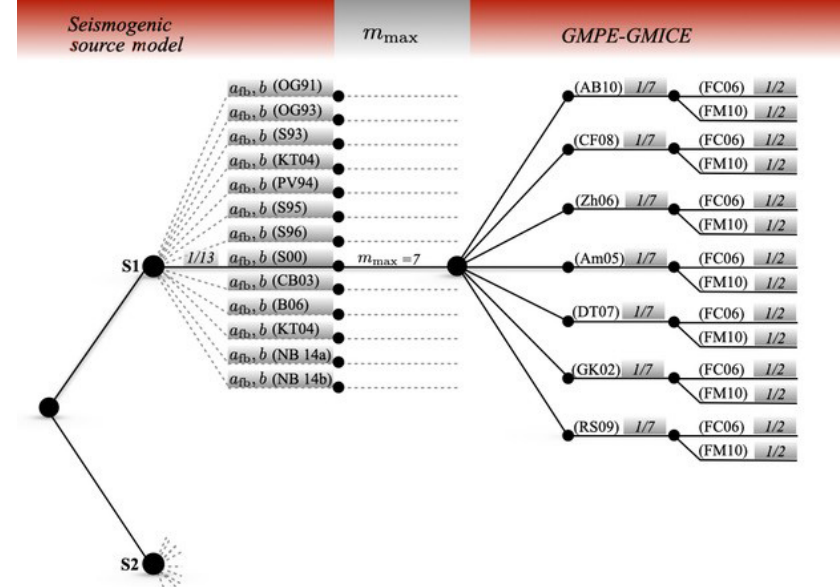
Figure 4. Logic tree for the PSHA analysis. The weight is reported in the grey boxes (e.g., in the SM1 model each a fb − b combination has uniform weight of 1 / 13, each GMPE has a uniform weight of 1 / 7, and each GMICE has uniform weight of 1 /